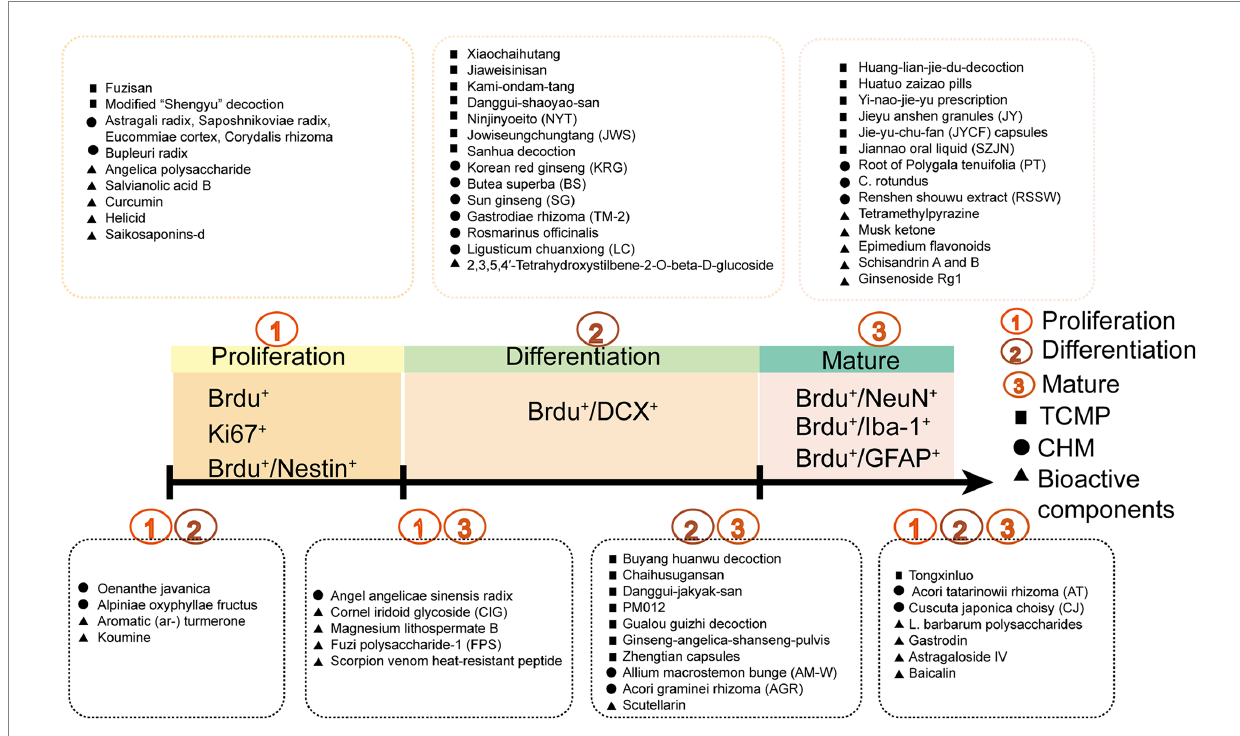
FIGURE 5 The influence of TCMPs, CHMs, and bioactive components on adult neurogenesis at different stages.